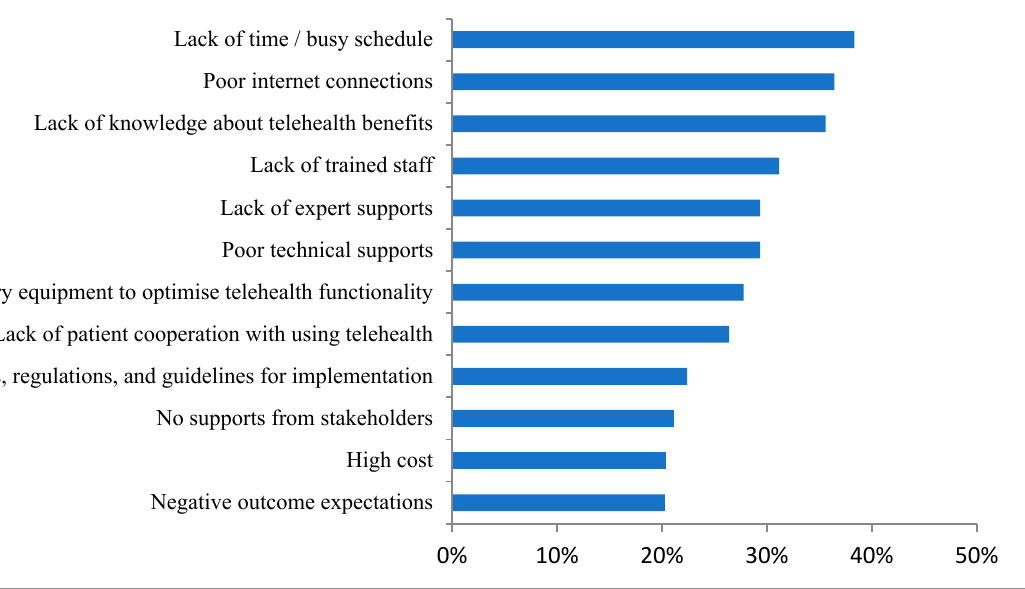
Figure 1. Barriers to Using Telehealth Applications among Healthcare Providers ( n = 947).